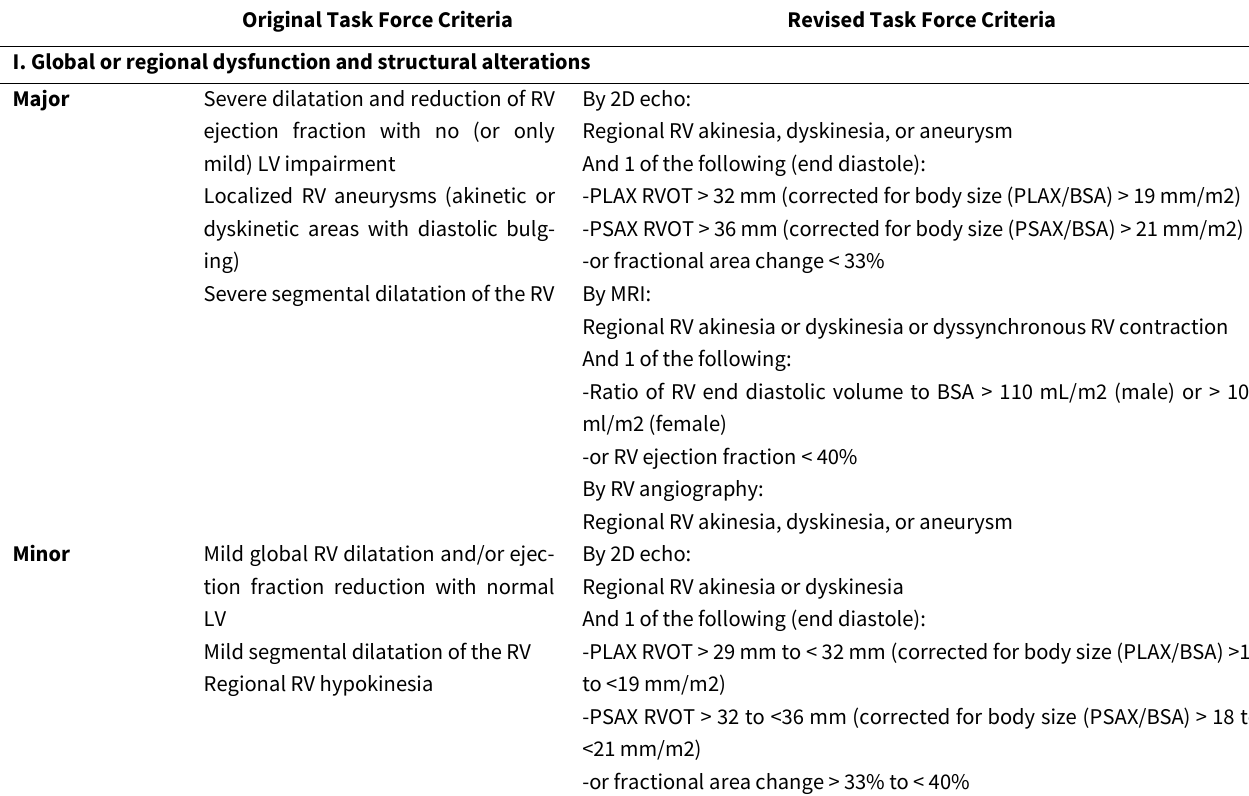
Table 1. Diagnostic Criteria of ARVC